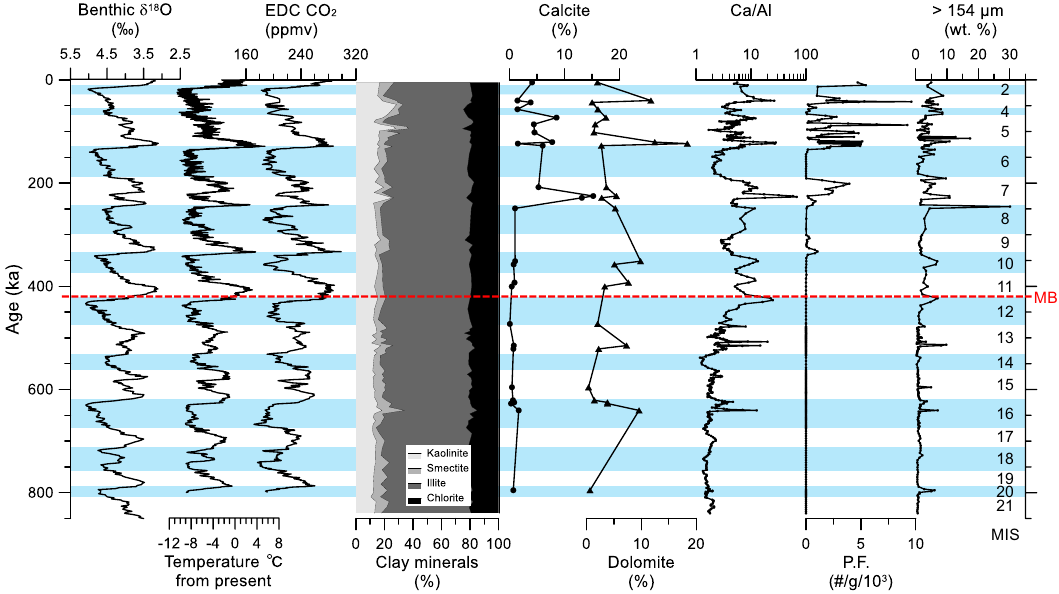
Figure 4. Downcore variation of mineralogical results (four major clay minerals (kaolinite, smectite, illite, and chlorite), calcite and dolomite contents, XRF Ca/Al ratio, planktonic foraminiferal (P.F.) abundance 9 , and coarse-grained (> 154 μm) fraction 9 ) of core ARC5-MA01 along with global benthic δ 18 O values 1 and EPICA Dome C (EDC) records, including air temperature 4 and atmospheric CO 2 concentration 5 . Marine isotope stages (MIS) are indicated with blue shadings of glacial periods and white shadings for interglacial periods. Please refer to the supplementary figure S1 for detailed downcore variations of major clay mineral contents.